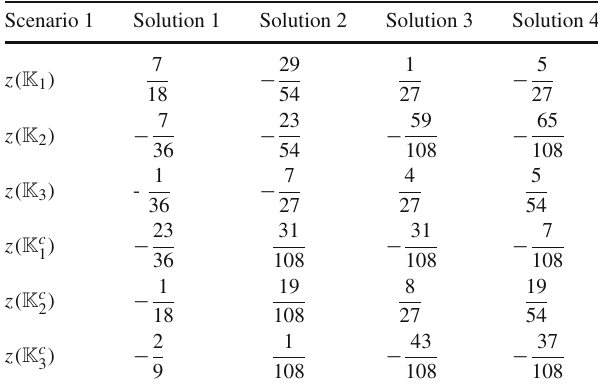
Table 22 The same as in Table 17, but with the minimal number of singlets under the SM gauge group n ν c = 5 , n S = 3 , n N = 1 and